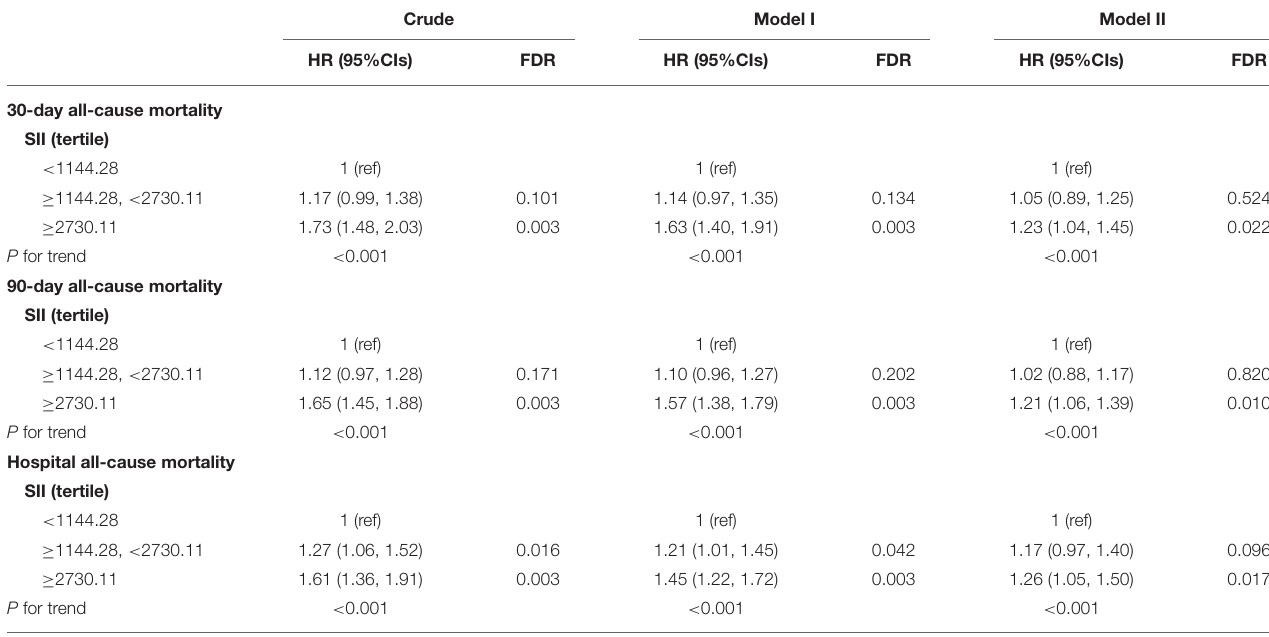
TABLE 2 | The univariate and multivariate Cox regression analysis exploring the association of SII tertile with short-term mortality of critically ill patients with CHF. Crude Model I Model